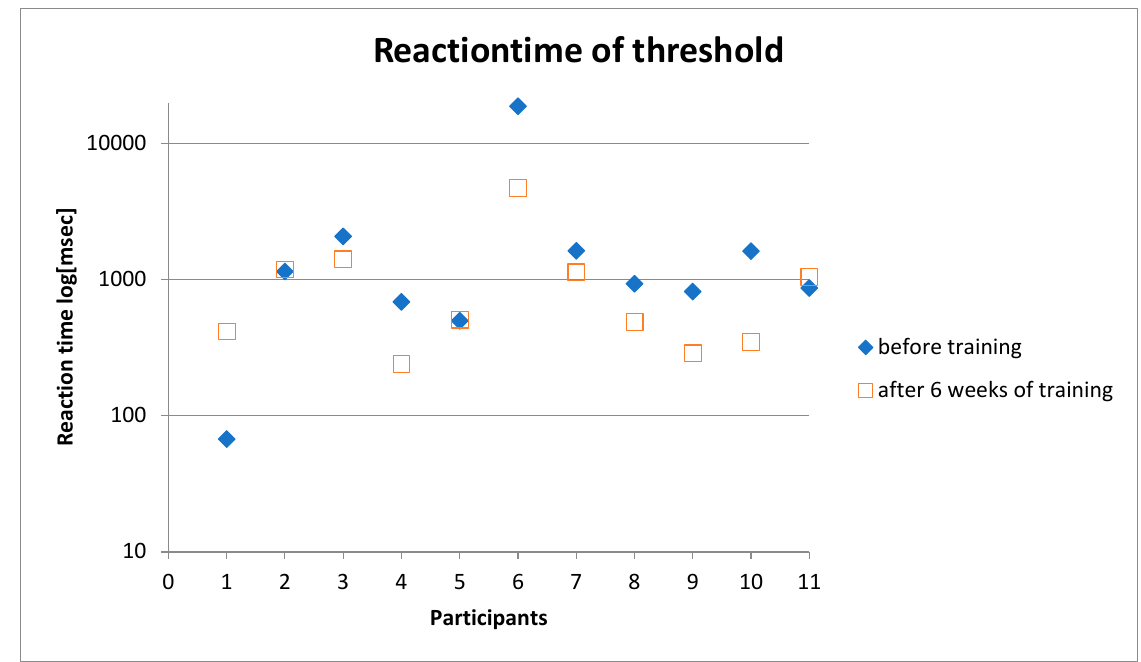
Figure 4. Reaction time recorded by the static test before training and after 6 weeks of training of every participant. Participant number six shows an improvement of 14.131 msec, so the reaction times were presented as a logarithmic scale in milliseconds.